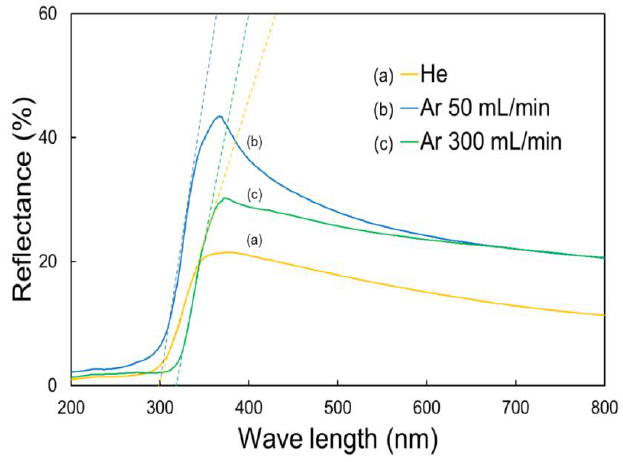
Figure 6. UV-vis diffused reflectance spectra for TiO 2 thin films deposited using atmospheric pres- sure plasma jet at fixed flow rate (500 mL/min) of titanium ethoxide precursor and (a) He = 5L/min (b) He = 5L/min + Ar = 50mL/min and (c) He = 5L/min + Ar = 300 mL/min. (b) He = 5L/min + Ar = 50mL/min and (c) He = 5L/min + Ar = 300